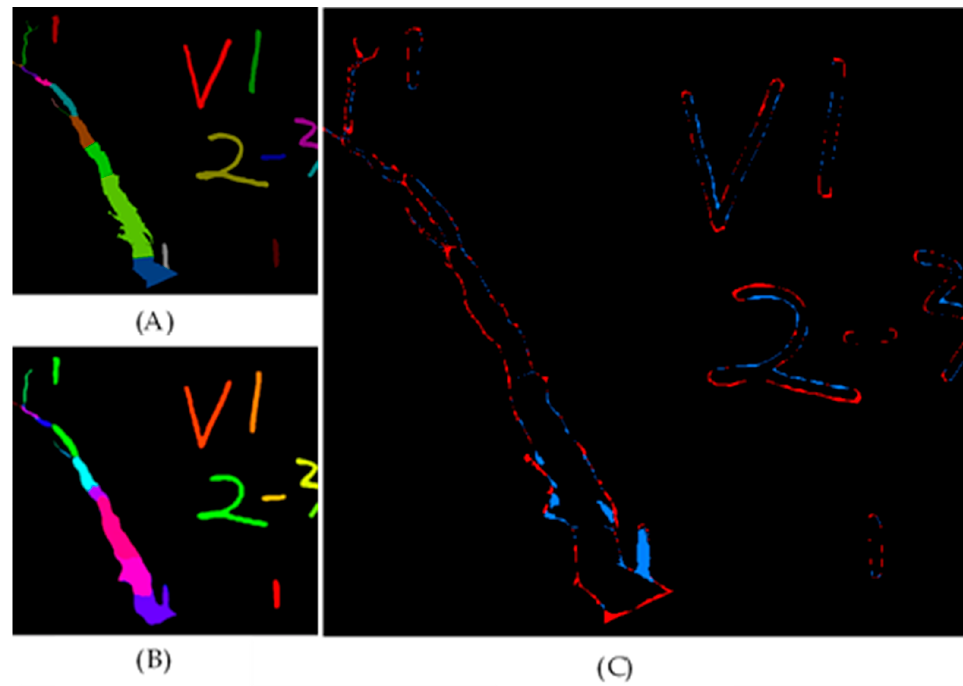
Figure 13. Comparison between real target detection and predicted target detection. ( A ) Real target image; ( B ) predicted target image; ( C ) compared target image.